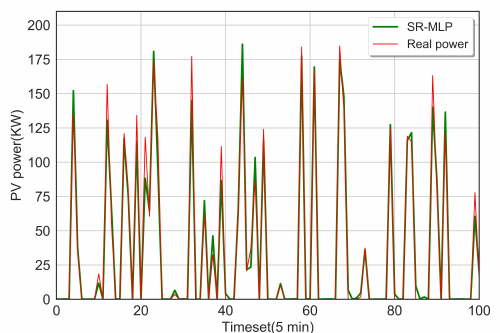
Figure 12. A capture of the SR-MLP Cross-Validation from [0,100] (high resolution).